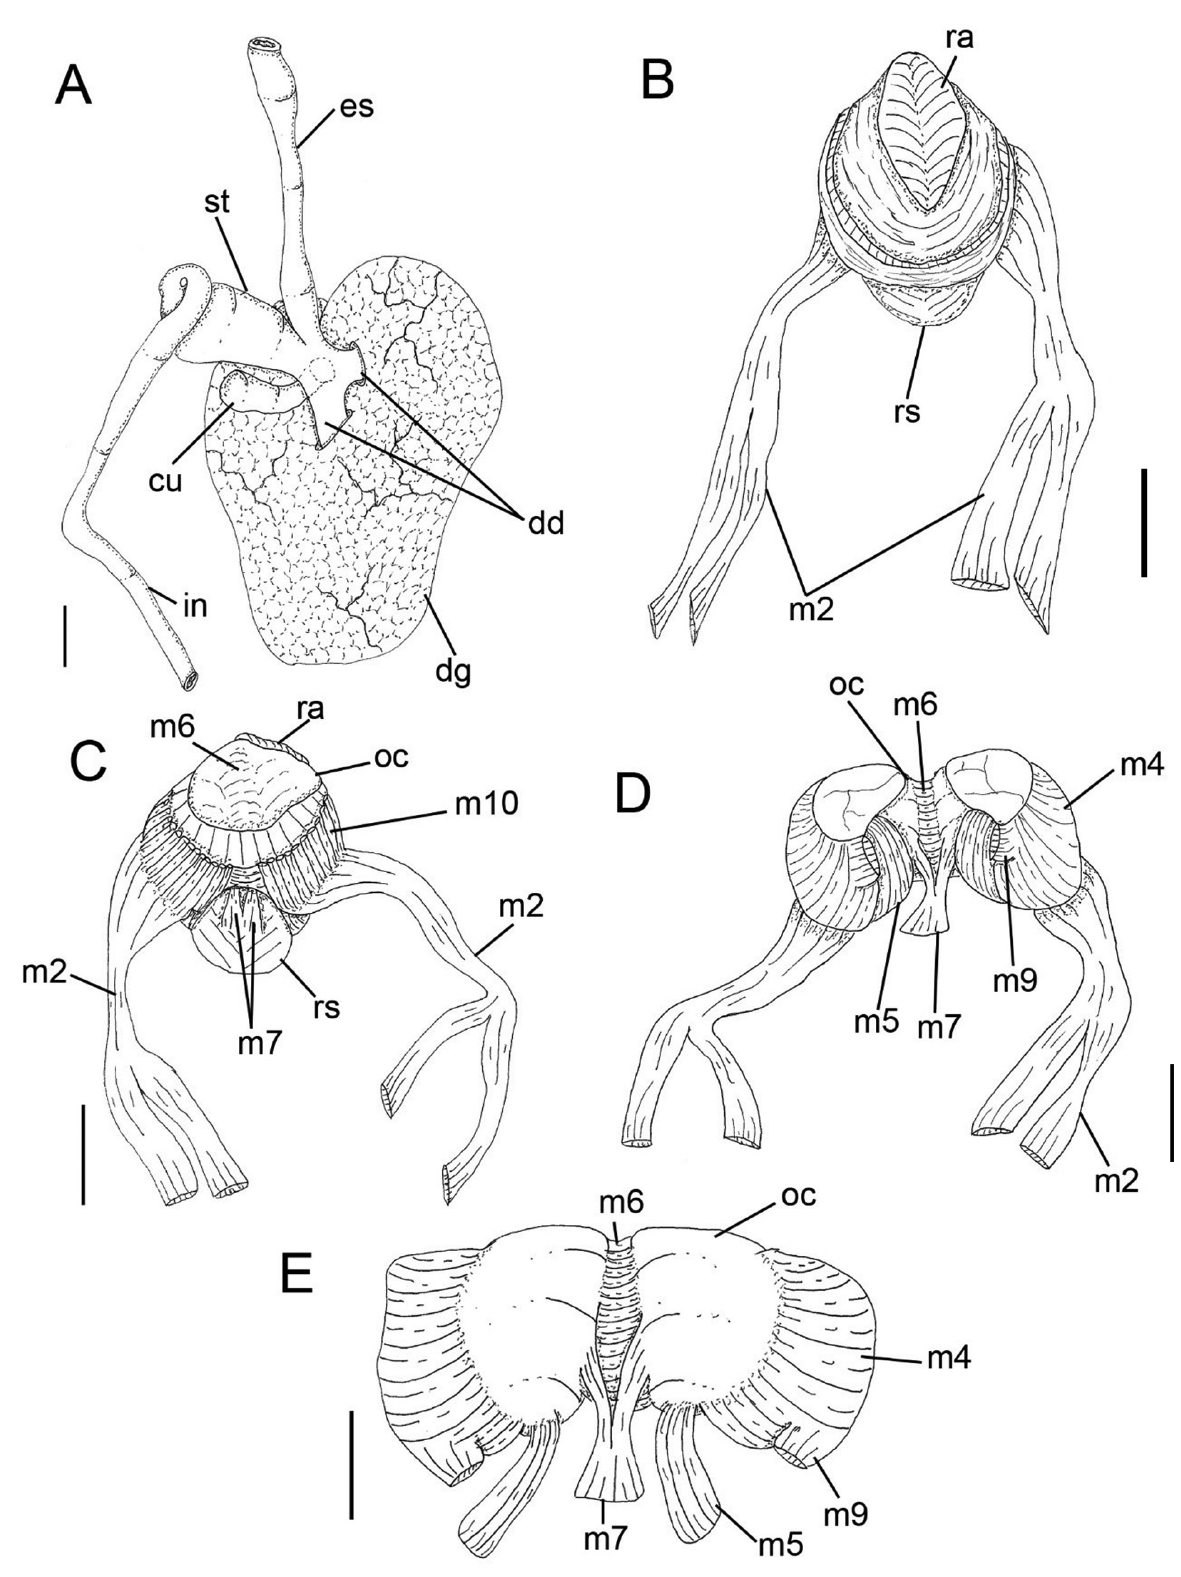
Figure 3. Platydoris angustipes . A medium digestive system. Odontophore B dorsal view with radula C same, ventral view D same, dorsal view with removed radula E same, dorsal view with folded down muscles. Scale bars: 2